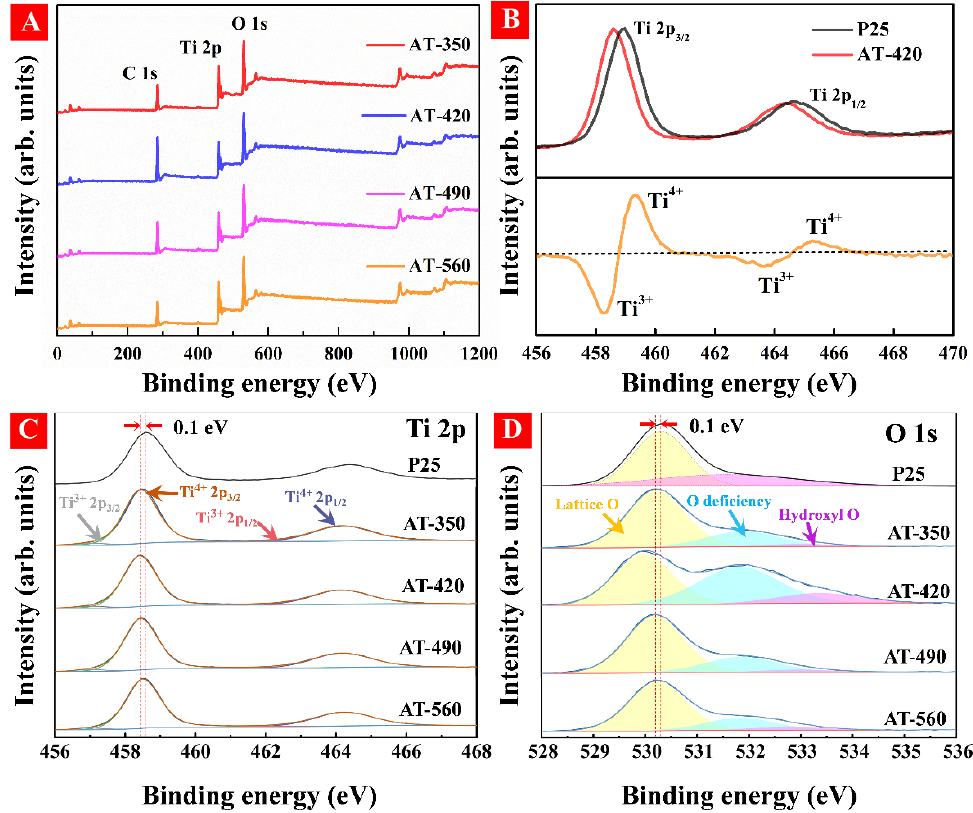
Figure 4. ( A ) Full XPS spectra for all samples, ( B ) Ti 2p spectra of AT-420 and P25 TiO 2 . The deconvoluted Ti 2p ( C ) and O 1s ( D ) spectra for all samples. Table 2. Bandgap, valence band maximum, and Ti 3+ /Ti 4+ ratio of the HAm-TiO 2 − x